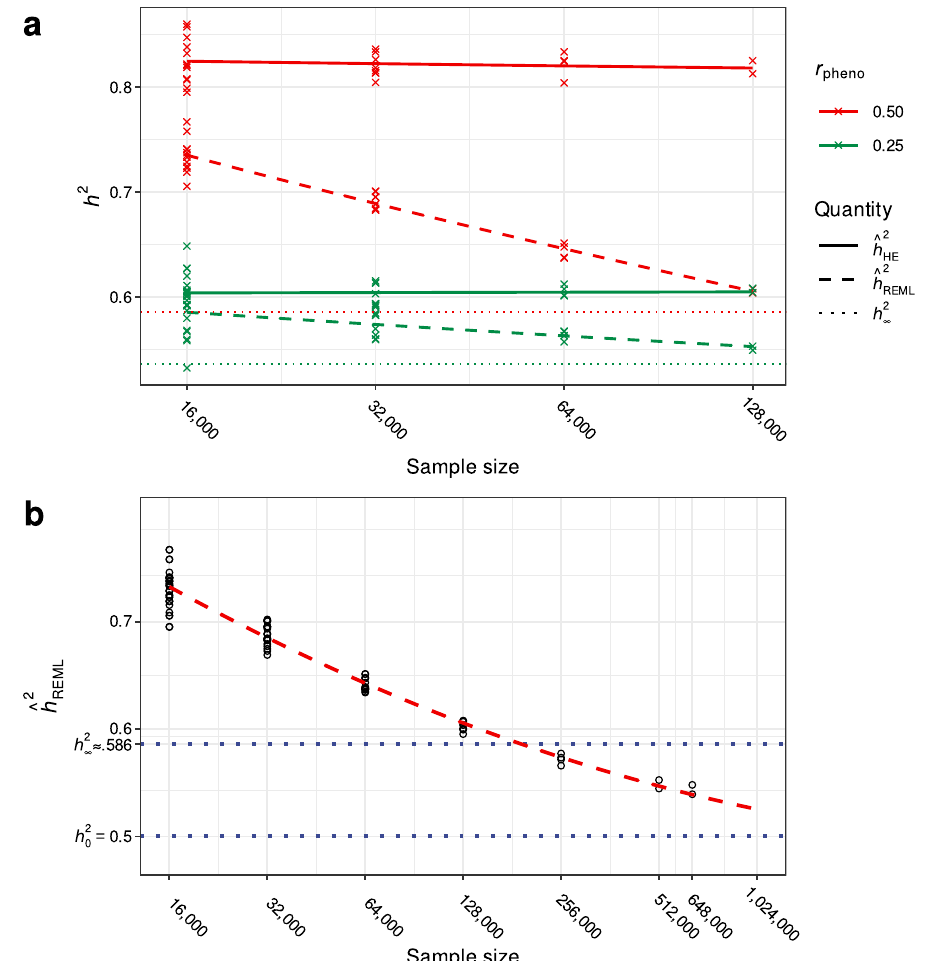
Fig. 2 REML and HE estimates across varying sample sizes in simulated data. a Comparison of HE regression and REML heritability estimates as functions of sample size for varying phenotypic mating correlation ( r pheno ) and fi xed panmictic heritability ( h 2 ¼ 0 : 5) in simulated data. We computed 0 multiple estimates per sample size for each estimator and parameter combination by applying estimators to independent sub-samples. Whereas HE regression estimates are upwardly biased independent of sample size, REML estimates slowly converge to the panmictic heritability as sample sizes increase. b Extended simulations demonstrating high-dimensional behavior of the REML estimator as a function of sample size. Forward time simulations required a larger population size ( N sim ¼ 3 ´ 10 6 ) to obtain samples of up to n ¼ 648 ; 000 unrelated individuals. Obtaining REML estimates for samples larger than this was not computationally feasible, but the dashed red line shows predicted values for larger sample sizes extrapolated from a regression model including fi rst and second order log-linear components. Results are consistent with theoretical predictions that the REML estimator converges to the panmictic heritability in very large